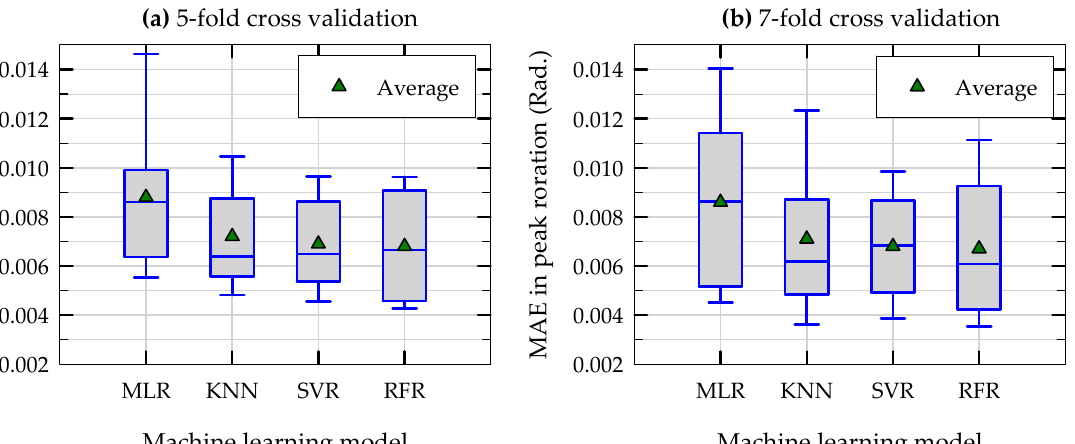
Figure 14. Boxplots of mean absolute errors (MAE) in predictions of peak rotations of machine learning models (k-fold testing error): ( a ) repeated 5-fold cross validation and ( b ) repeated 7-fold cross validation.